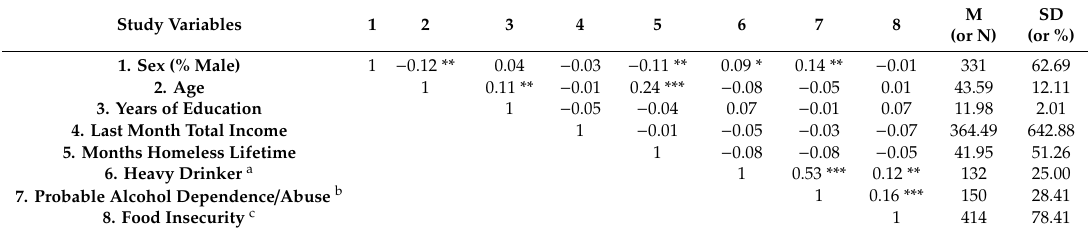
Table 1. Sample descriptives and correlations between study variables (N =